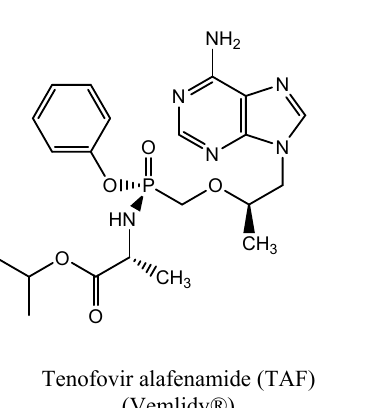
Figure 2. Prodrugs of PMEA (adefovir) and ( R )-PMPA